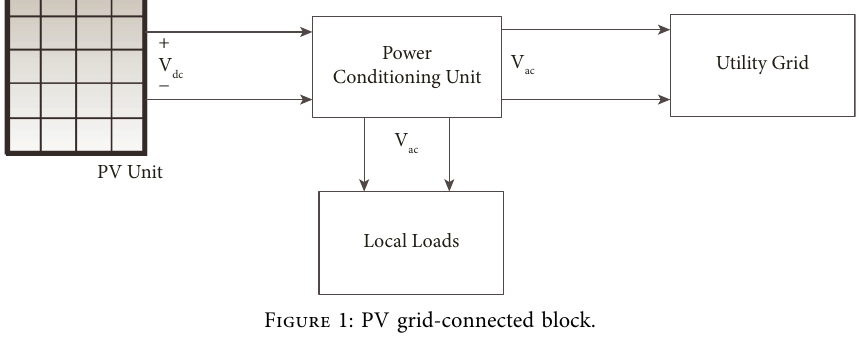
Figure 1: PV grid-connected block.